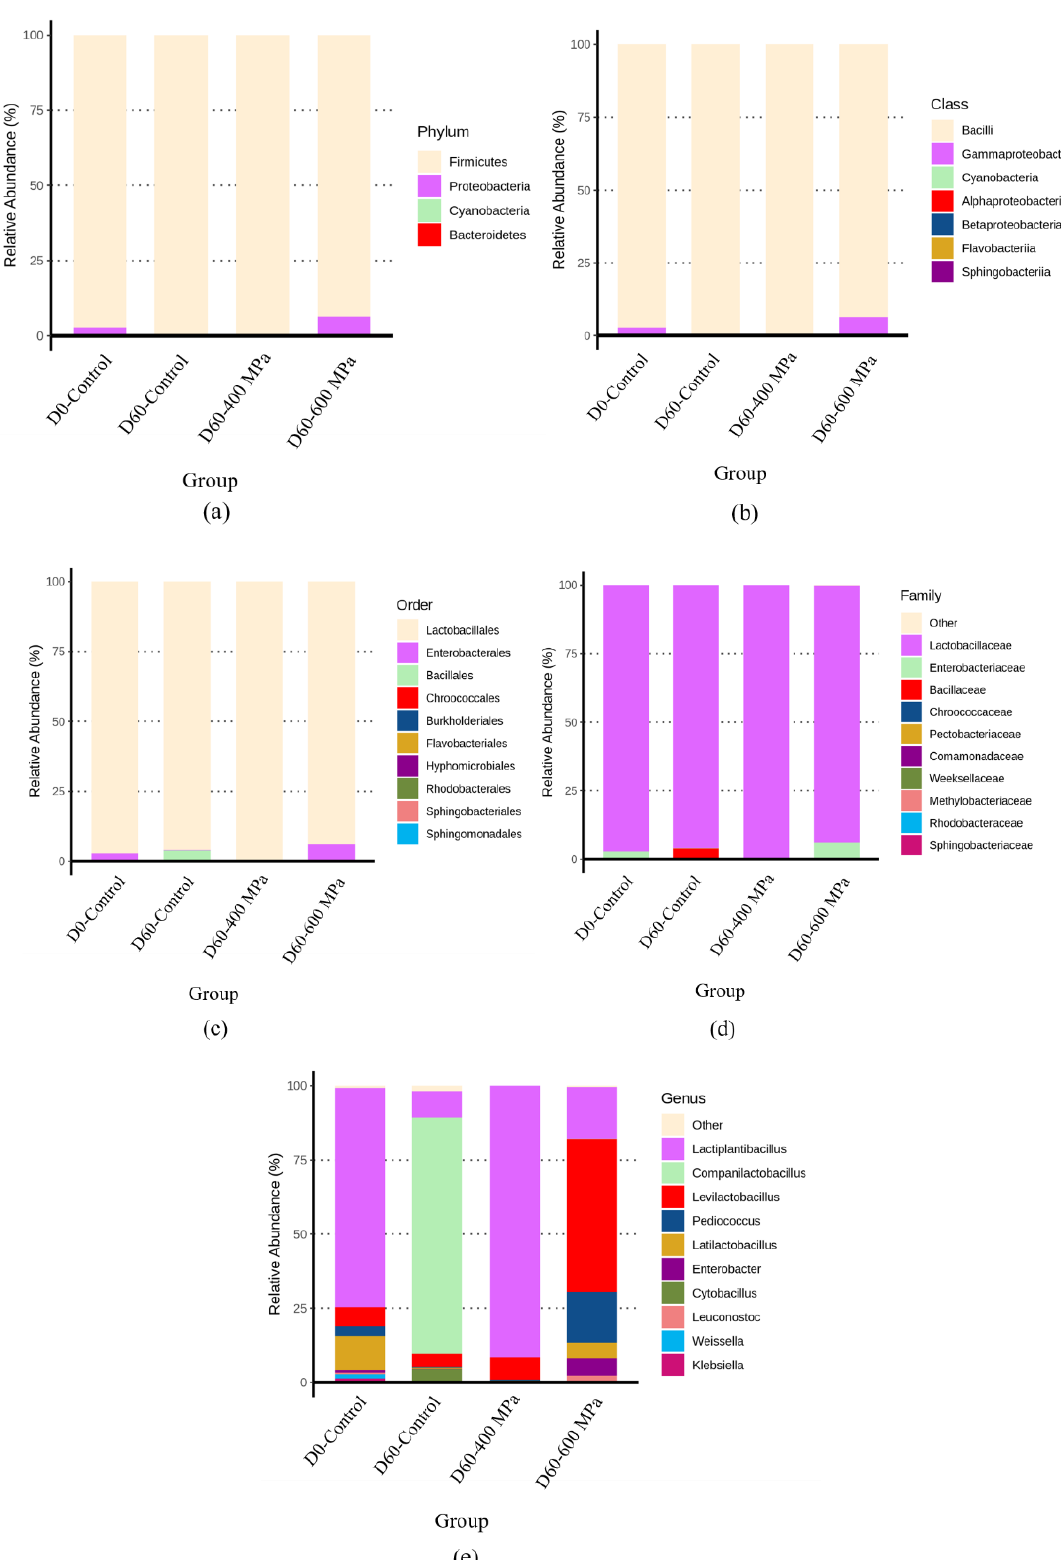
Figure 4. Bacteria species annotation of mustard pickle products on the levels of ( a ) phylum, ( b ) class, ( c ) order, ( d ) family, and ( e ) genus, as a result of the non-HHP group (D0-Control), non-HHP group stored at 25 °C for 60 days (D60-Control), and 400 MPa group (D60-400 MPa) and 600 MPa group (D60-600 MPa) stored at 25 °C for 60 days.